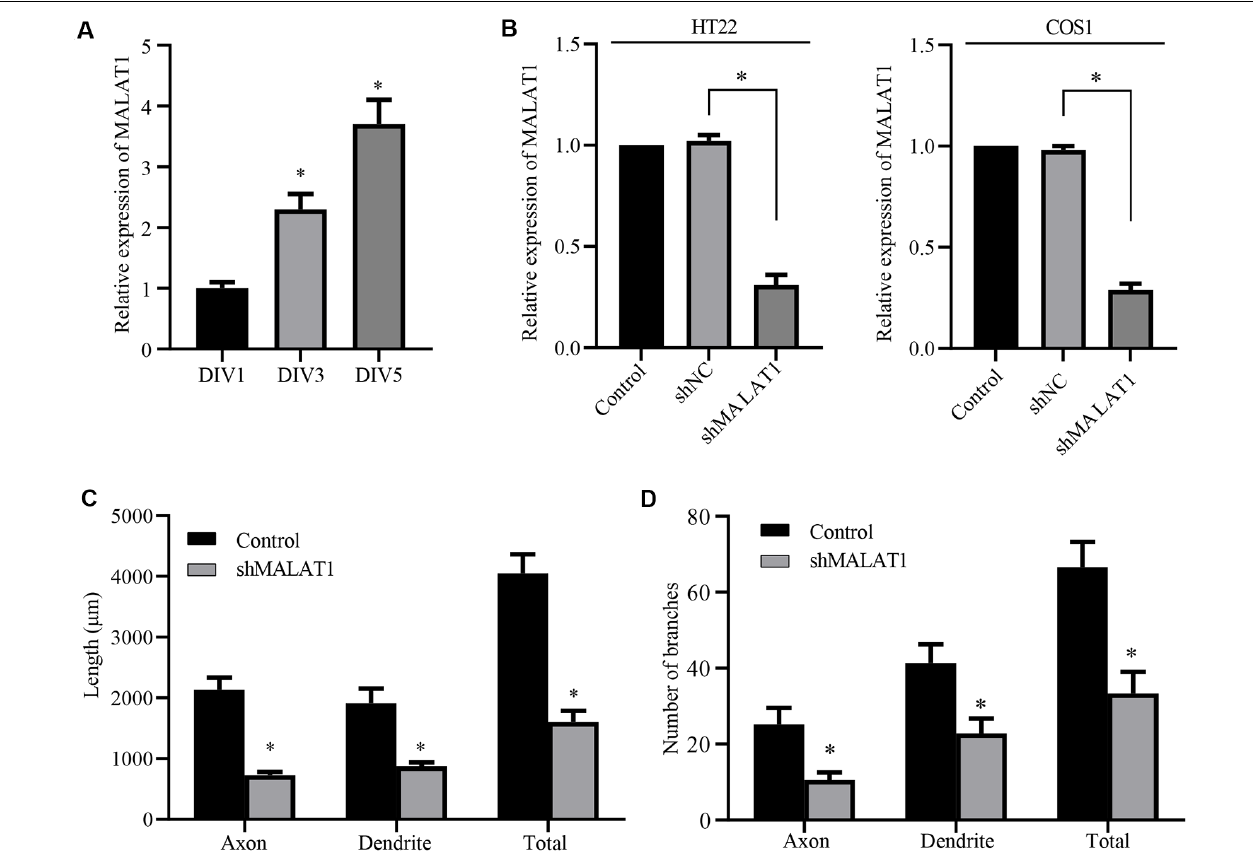
FIGURE 3 | Long non-coding RNA (lncRNA) MALAT1 is critical for neurite outgrowth of hippocampal neurons. (A) qPCR data shows that the levels of lncRNA MALAT1 increased during hippocampal neuronal development. (B) Plasmids targeting MALAT1 (shMALAT1) were transfected into the HT22 and COS1 cells, and the expression levels were determined by qPCR. DIV3 hippocampal neurons were transfected with shMALAT1 plasmids, and the lengths (C) and the number of branches (D) were counted. ∗ P < 0.05; n = 3.